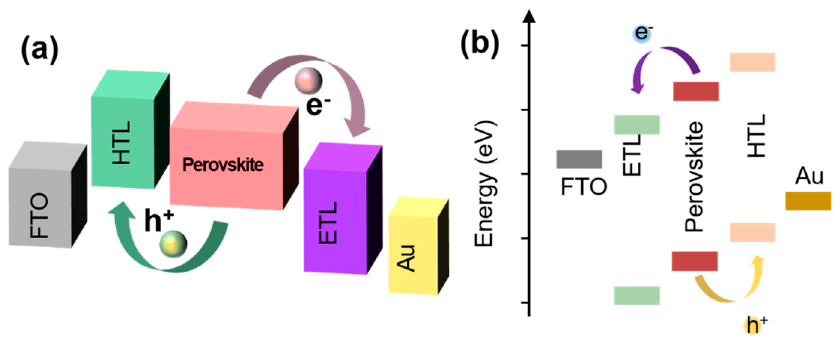
Figure 4. Schematic diagram of charge transfer of ( a ) inverted and ( b ) conventional PSCs.